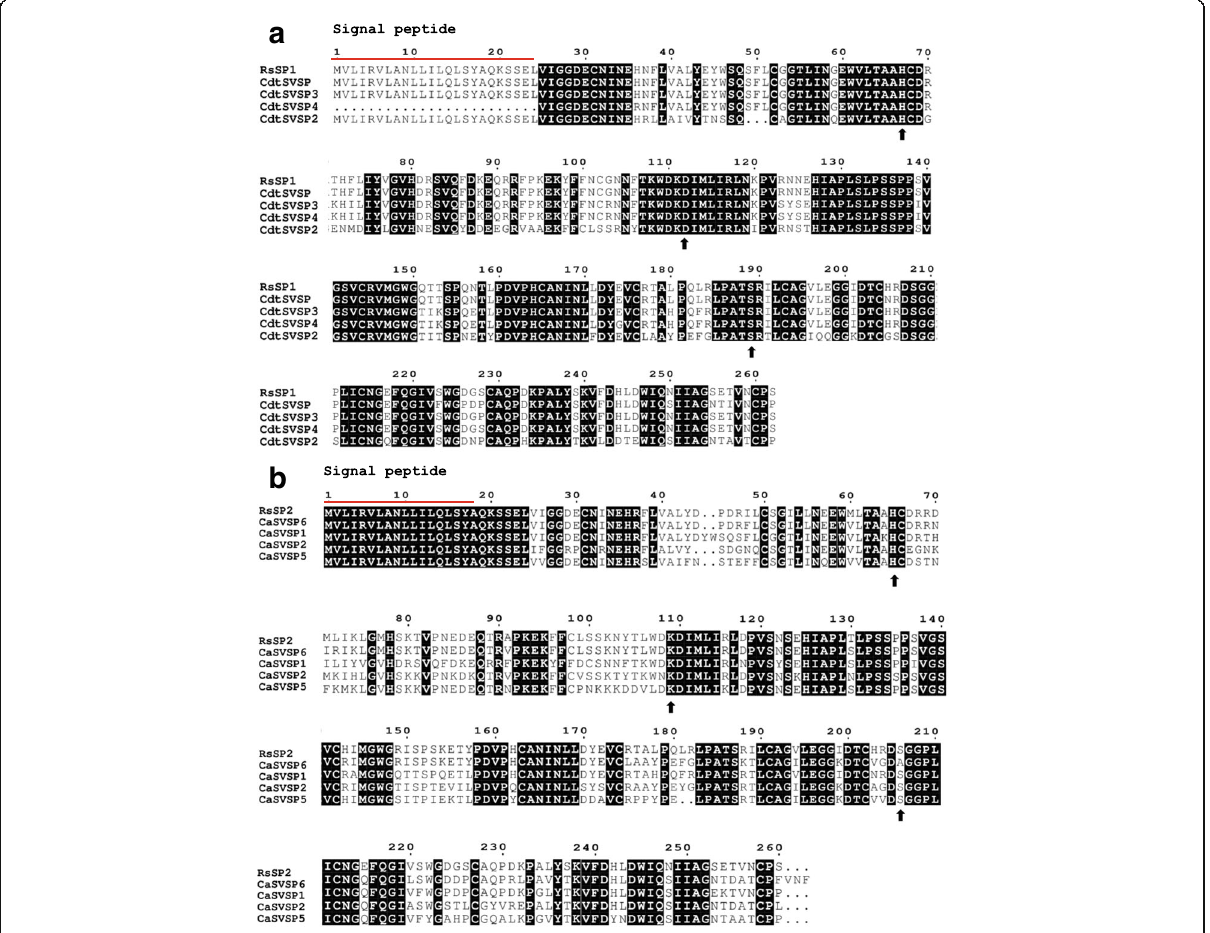
Fig. 3 Sequence alignment of serine protease discovered in this transcriptome (RsSP) and those from different snake venoms (SVSP) available in datadases. a Alignment of protein codified by contigs TRINITY_DN87578_c1_g1_i3, TRINITY_DN87578_c1_g1_i4 and TRINITY_DN87578_c1_g1_i8, named RsSP1 and gyroxin serine proteases from snake venoms (SVSPs) from Crotalus durissus terrificus (CdtSVSP3, VSP13_CRODU), CdtSVSP 2 (VSP21_CRODU) CdtSVSP4 (VSP14_CRODU). b Alignment of serine protease codified by contigs TRINITY_DN87578_c1_g1_i2, TRINITY_DN87578_c1_g1_i5 and TRINITY_DN87578_c1_g1_i6, named RsSP2 and gyroxin SVSP from Crotalus adamanteus 1, CaSVSP1 (VSP1_CROAD), CaSVSP2 (VSP2_CROAD),